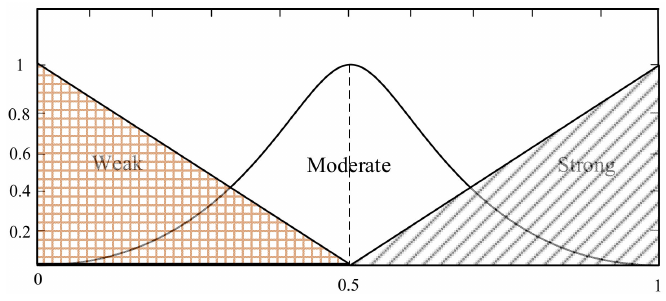
Figure 6. Mixture member function